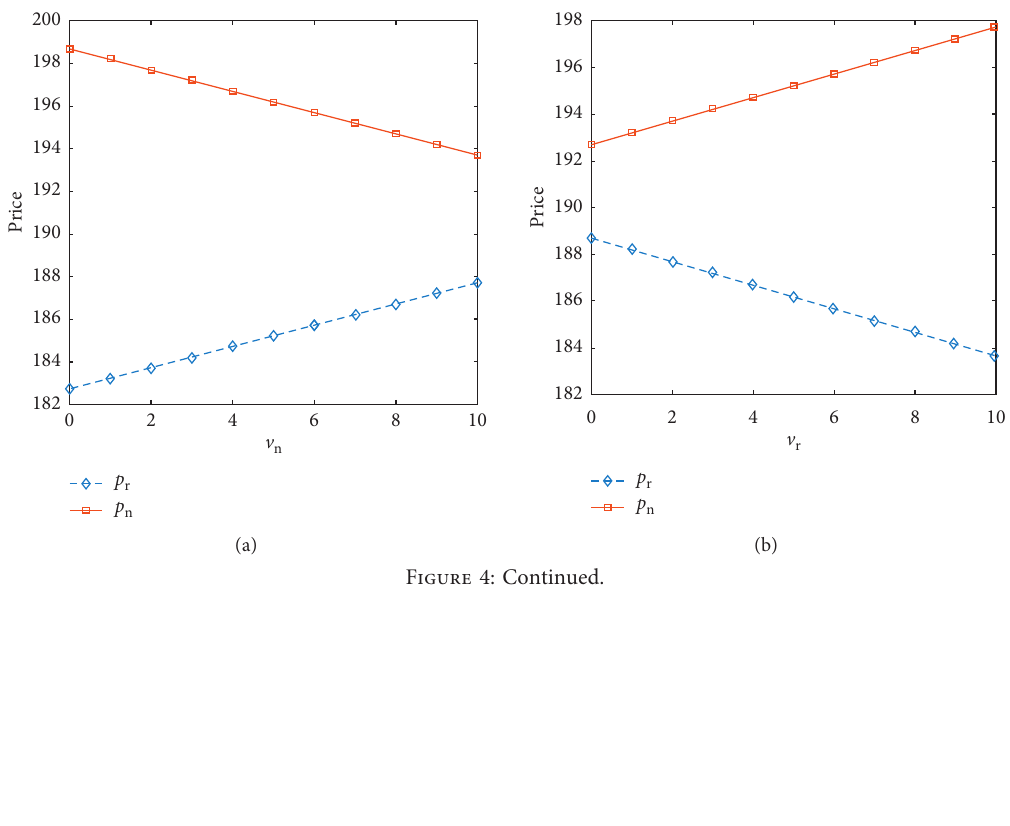
and e on recycling prices p n r on recycling prices p n